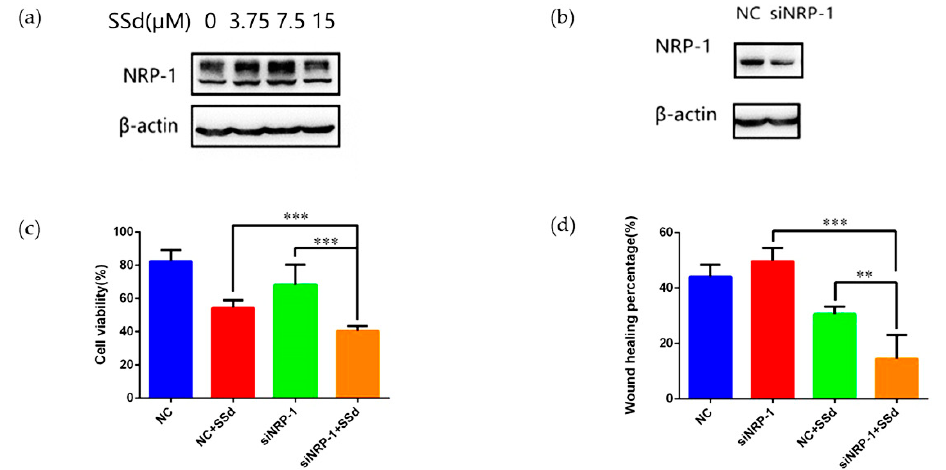
Figure 2. NRP-1 knockdown and effects of SSd on HepG2 in combination with NRP-1 knockdown. ( a ) The expression of NRP-1 affected by SSd; ( b ) knockdown of NRP-1; ( c ) the cell viability of HepG2 cells after knockdown of NRP-1 in combination with SSd, *** p < 0.001; ( d ) the wound healing percentage of HepG2 cells after knockdown of NRP-1 in combination with SSd, ** p < 0.01, *** p < 0.001.